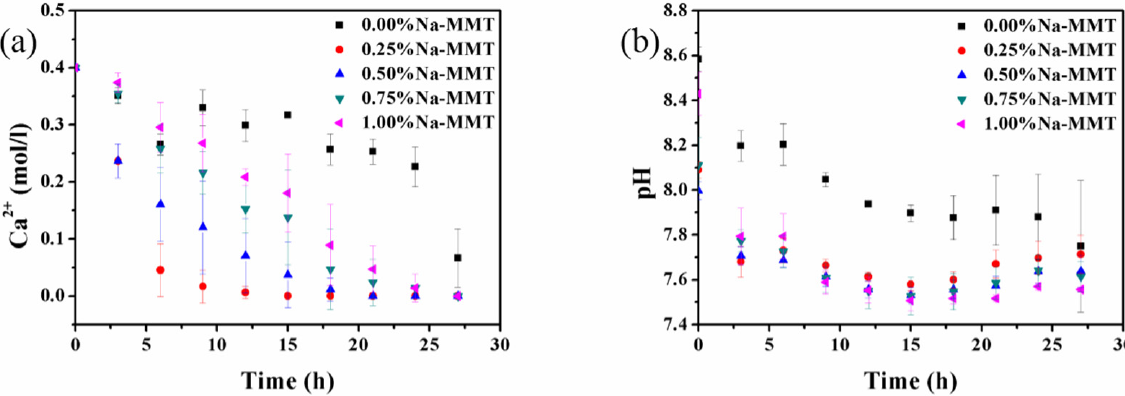
Figure 2. The change in the concentration of the Ca 2+ ions ( a ) and pH ( b ) with Na-MMT concentrations.